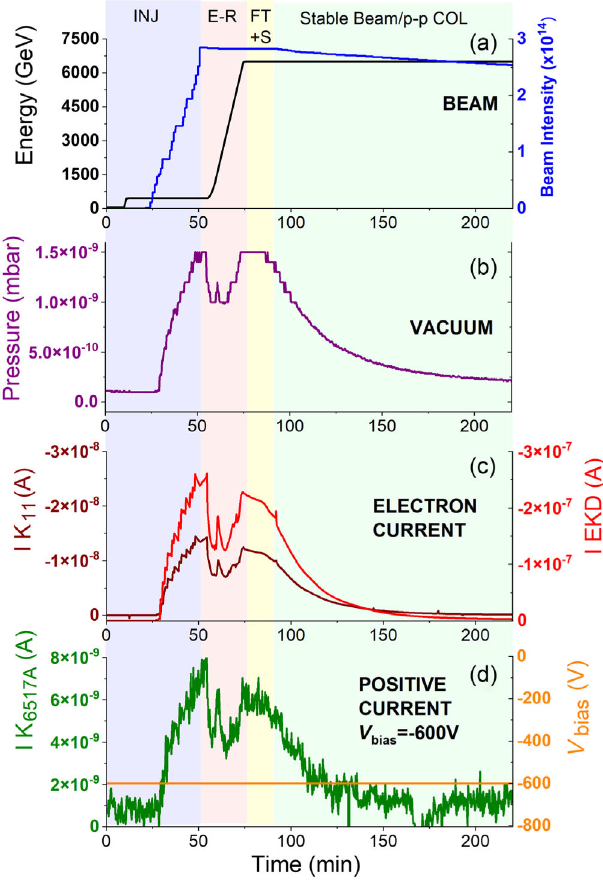
FIG. 2. Measurements performed in station 4 of the VPS during fill7319: Energyandintensity ofthebeam1 (a),pressure measured with a Bayard Alpert gauge (b), electron current collected with the K11 and EKD electrodes (biased at þ 9 V, the inner grid of EKD being not polarized in this case) (c), positive current collected with the K6517A electrode polarized at − 600 V (d); (INJ ¼ injection, E-R ¼ Energy, Ramp, FT þ S ¼ Flat, Top, and Squeeze).